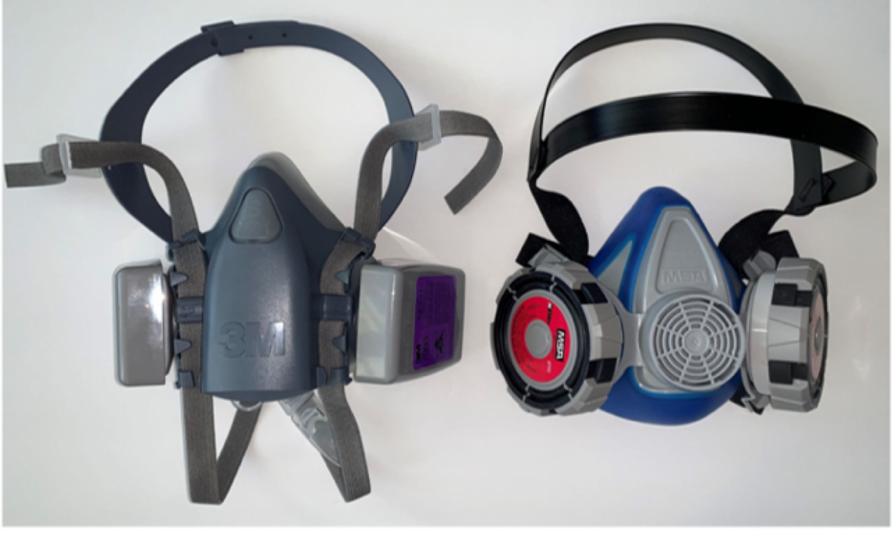
Figure 1. Examples of elastomeric